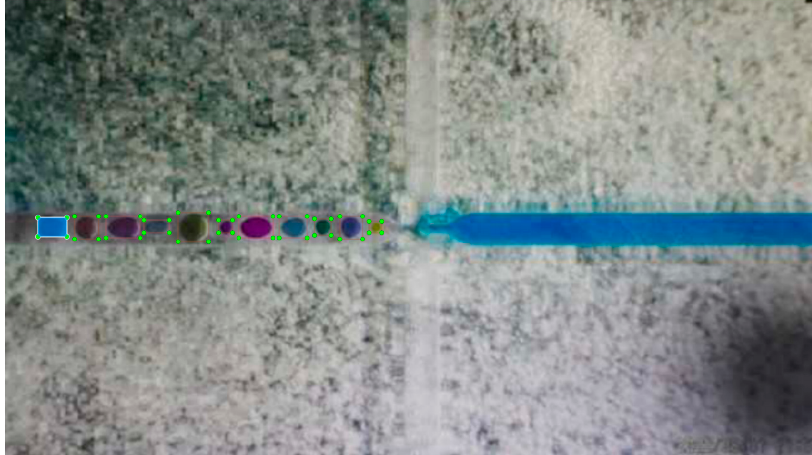
Figure 6. The labeled synthetic image sample. Table 1. The sample of synthetic image label storage